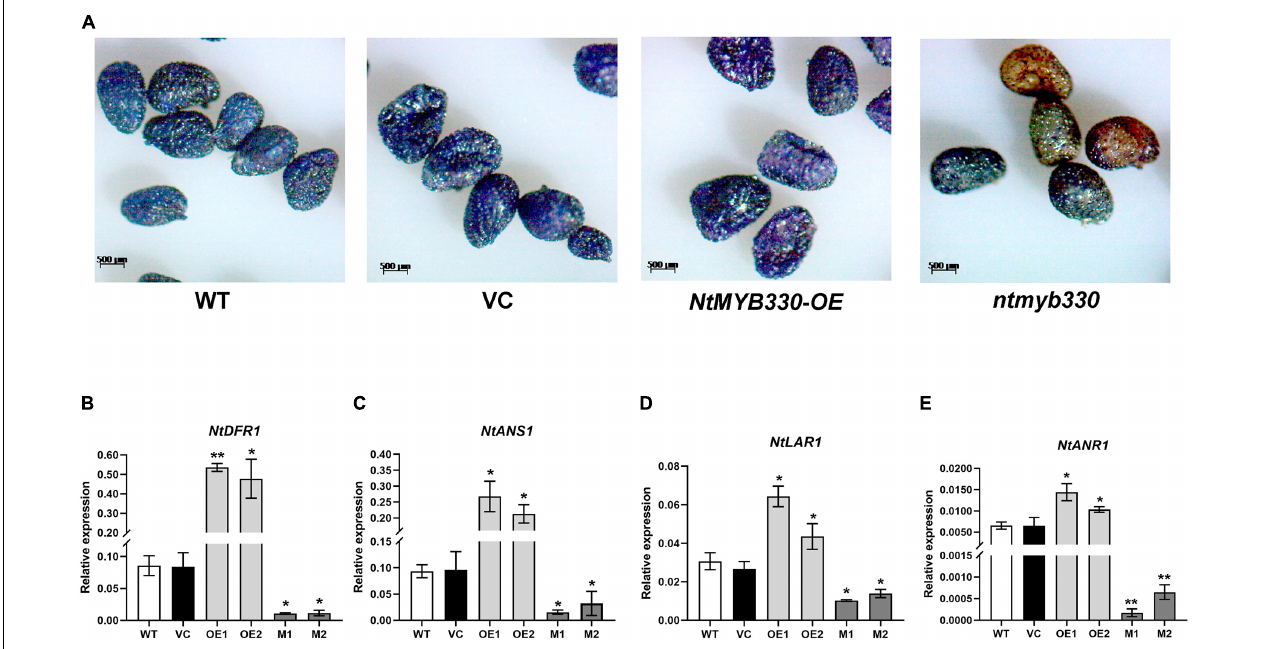
FIGURE 7 | NtMYB330 regulates PA biosynthesis in tobacco seeds. (A) DMACA staining of PAs accumulated in the seed coats of WT, VC, NtMYB330-OE and ntmyb330 mutant plants. Scale bar = 500 µ m. Relative expression levels of (B) NtDFR1 , (C) NtANS1 , (D) NtLAR1 and (E) NtANR1 in the seeds of WT, VC, NtMYB330-OE and ntmyb330 mutant plants. Data are the mean of three replicates with error bars indicating ± SD. Asterisks indicate statistically significant differences from WT according to paired t -test (* P < 0.05; ** P <